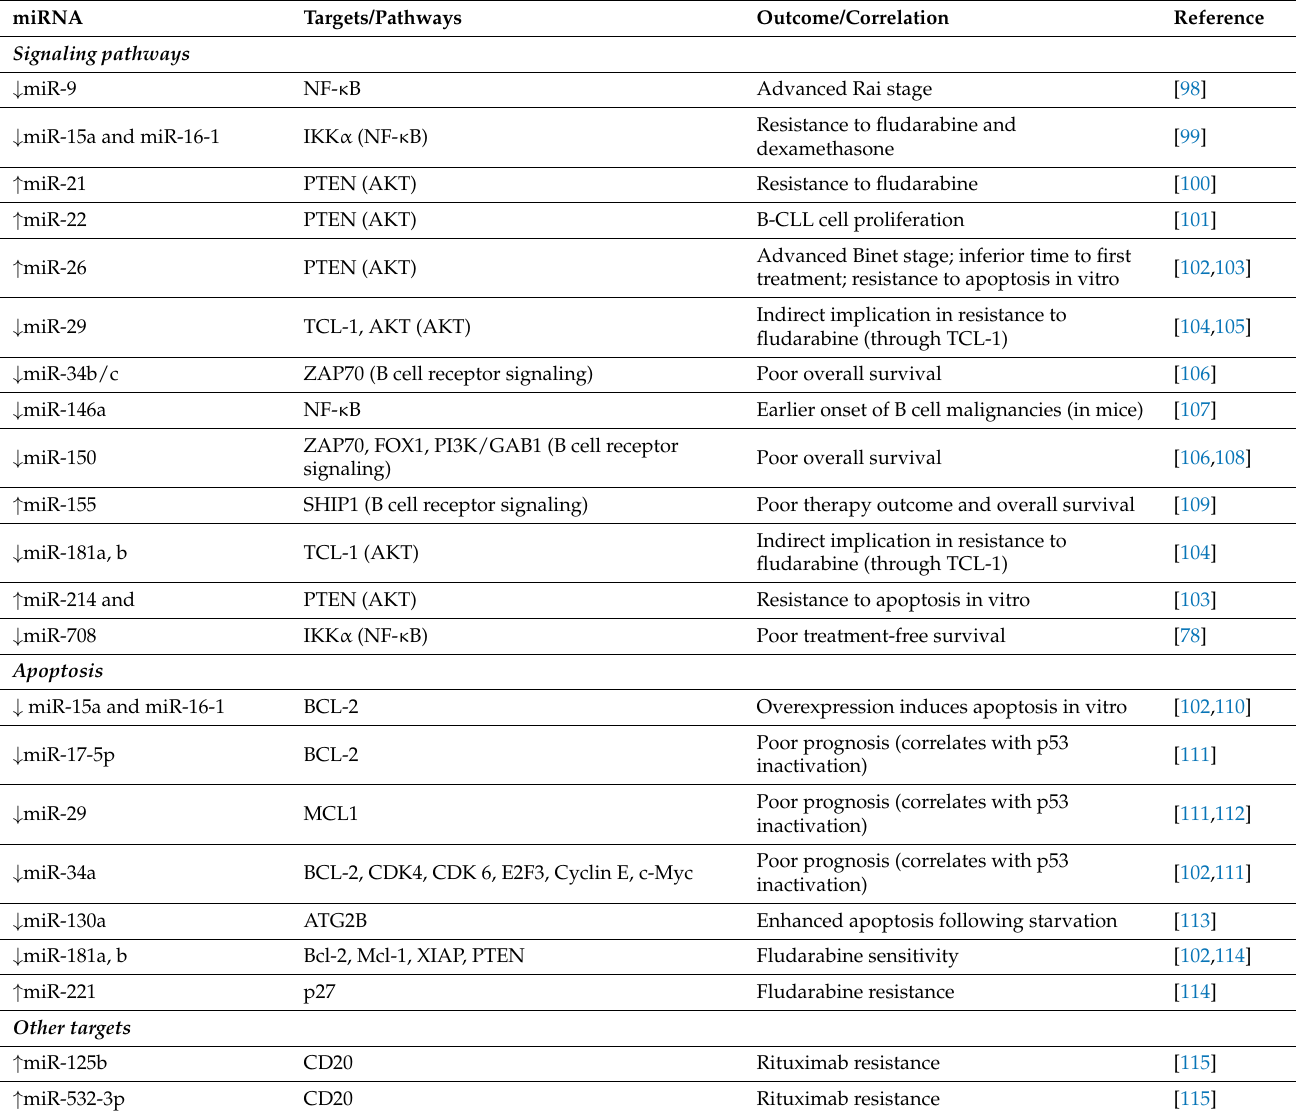
Table 3. miRNAs, their targets and their effects in